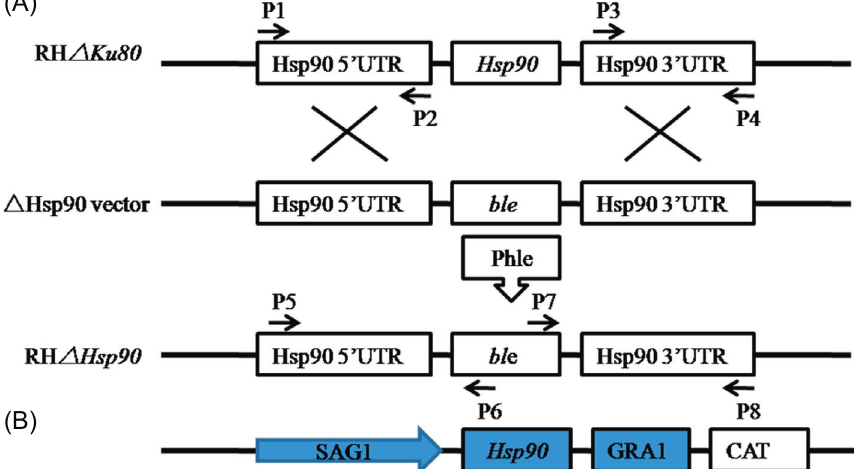
Figure 1. Generation of Tg Hsp90 knockout ( D Hsp90 ) and complementation parasites. (A) Schematic illustration of the strategy used to generate the Tg Hsp90 knockouts by homologous recombination. The Hsp90 coding region was replaced by the selectable marker Ble ; the knockout vector was transfected into the RH D ku80 strain and selected by phleomycin. (B) Diagram of genetic complementation of Hsp90. An Hsp90 coding sequence and the CAT selection marker, which was flanked by T. gondii Tublin promoter and 3 0 poly A signal (provided by Professor Liuqun, College of Veterinary Medicine, China Agricultural University), was transfected into the Tg Hsp90 defective strain to generate the complemented